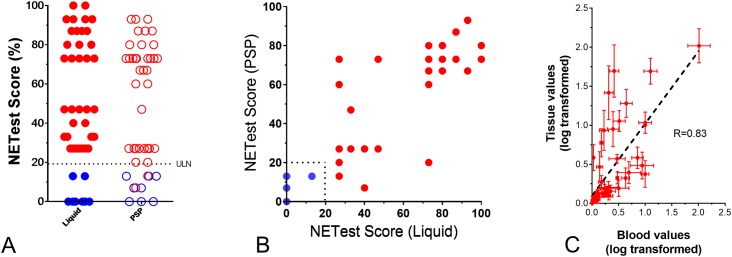
Relationship between NETest scores in the standard approach and PSPs in Sample Set I (n = 44).3A. The mean and median NETest scores were not significantly different (p = 0.674) between liquid (mean: 49.7; median: 47) and PSPs (mean: 48.5; median: 60). 3B. The Pearson correlation for the NETest score was 0.873 (95%CI: 0.78–0.93), p<0.0001. Blue = controls (n = 8), red = NETs (n = 36). 3C. Graph plot of the averaged log-transformed gene expression of matched blood-tissue pairs. Error bars indicate standard error of the mean. The dotted line represents the best linear fit line. Regression analysis identified R to range from 0.71–0.83 (n = 7, p<0.0001). ULN = upper limit of normal.